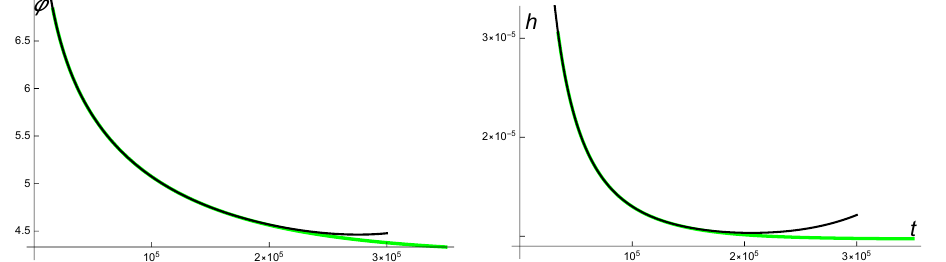
Figure A1. The green lines show the numerical solutions ϕ ( t ) of (9) ( left ) and h ( t ) (10) ( right ) with initial conditions t 0 = 1000, ϕ 0 = ϕ (cid:114) (+) − ( t ) 2 − v ( ϕ ) . The black lines show the 6-order approximations ϕ (+) h 0 , b 0 ,0 0 approx ,6 (+) ) (right). The model parameter values are λ = ( t , b (left) and h 0 ,0 approx ,6 c 2 = 2.5 × 10 − 10 .